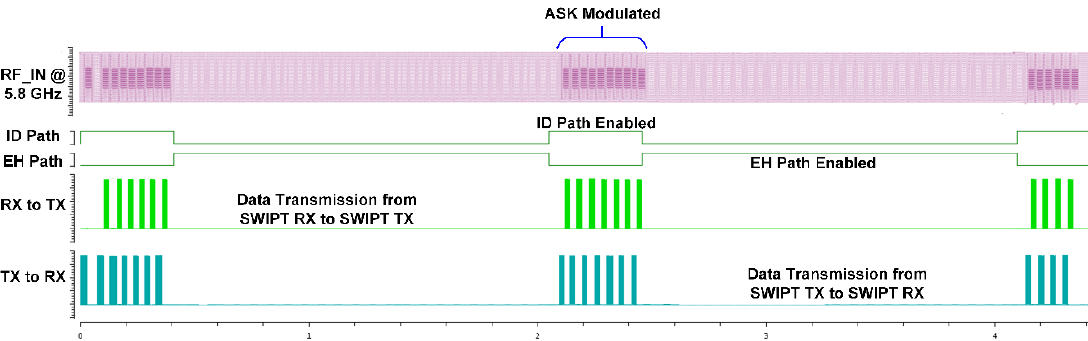
Sensors 2021 , 21 , x FOR PEER REVIEW 20 of 23 Figure 23. Data communication between the SWIPT transmitter and SWIPT receiver with a time switching scheme. Figure 23. Data communication between the SWIPT transmitter and SWIPT receiver with a time switching scheme. Figure 23. Data communication between the SWIPT transmitter and SWIPT receiver with a time switching scheme.